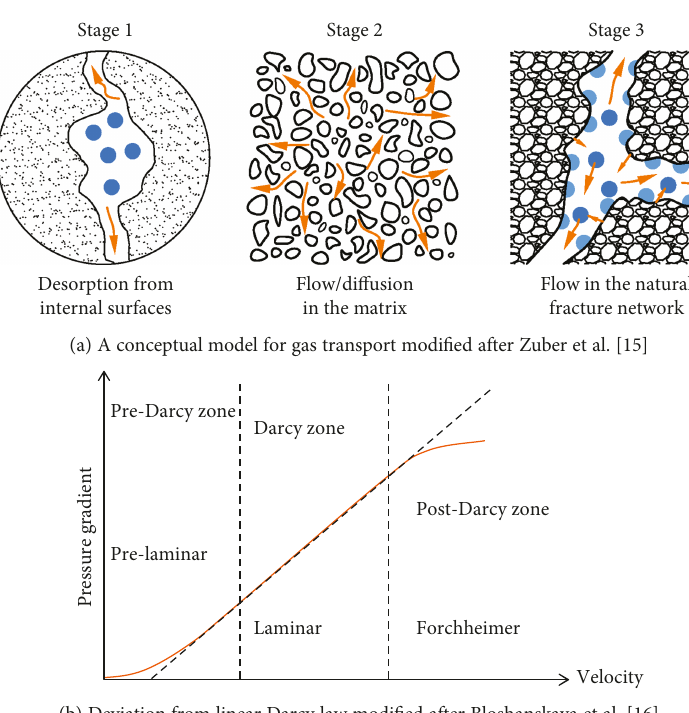
Figure 2: A conceptual model for gas transport in the coal seam [15,